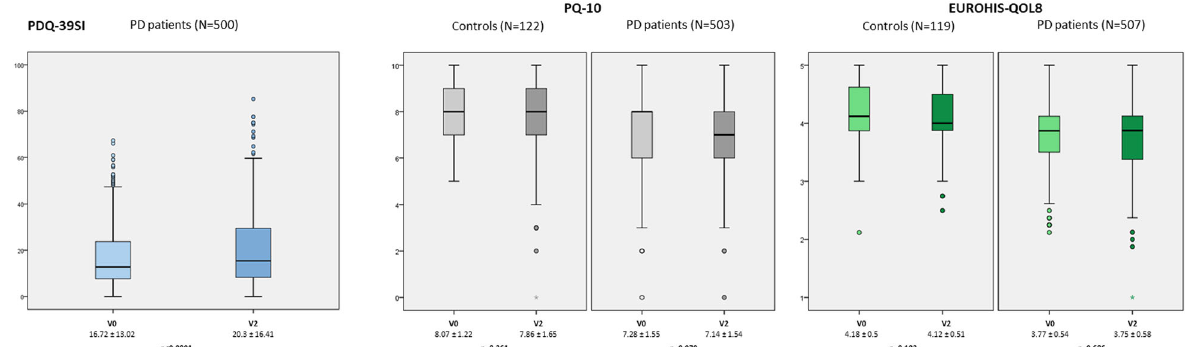
Fig. 1 Change in PDQ-39SI, PQ-10, and EUROHIS-QOL8 scores from V0 (baseline) to V2 (2 year ± 1 month) in PD patients and/or controls. Data are presented as box plots, with the box representing the median and the two middle quartiles (25 – 75%). p -values were computed using the Wilcoxon-signed rank test. Mild outliers (O) are data points that are more extreme than Q1 − 1.5 * IQR or Q3 + 1.5 * IQR. EUROHIS-QOL8, European Health Interview Survey-Quality of Life 8-Item Index; PDQ-39SI, 39-item Parkinson ’ s Disease Quality of Life Questionnaire Summary